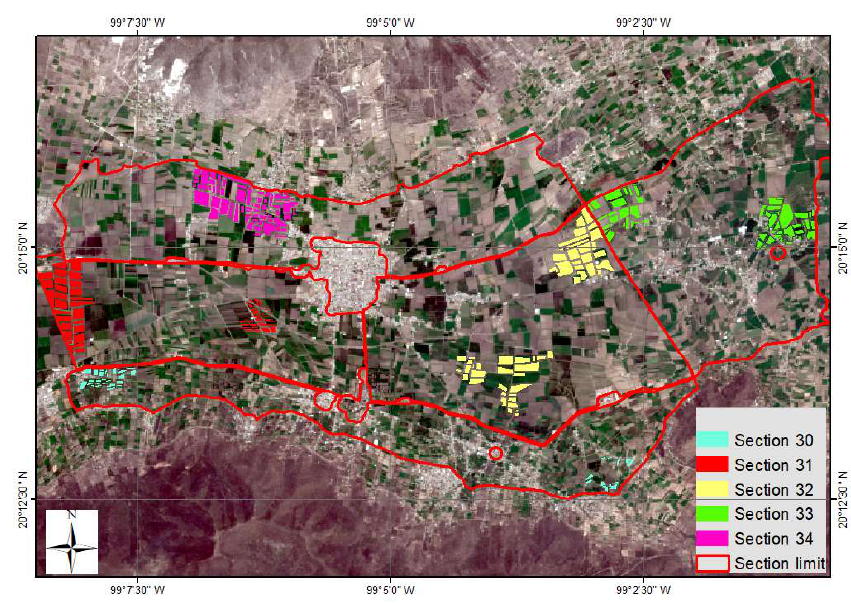
Figure 4. Parcels (clusters) by section grouped and monitored during the crop cycle